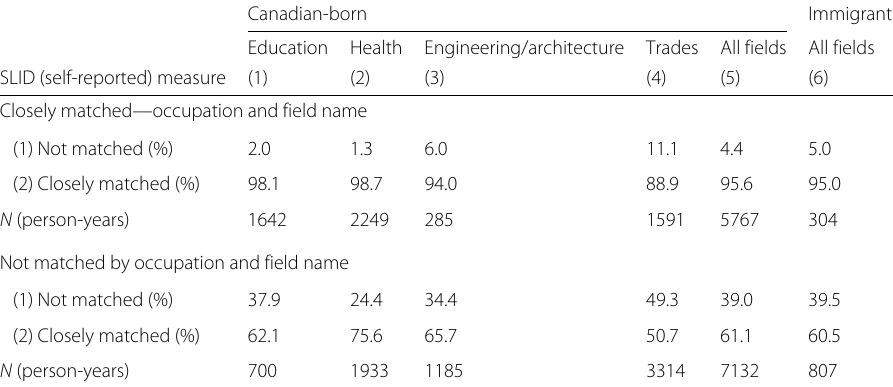
Table 17 SLID job match vs. occupational/field